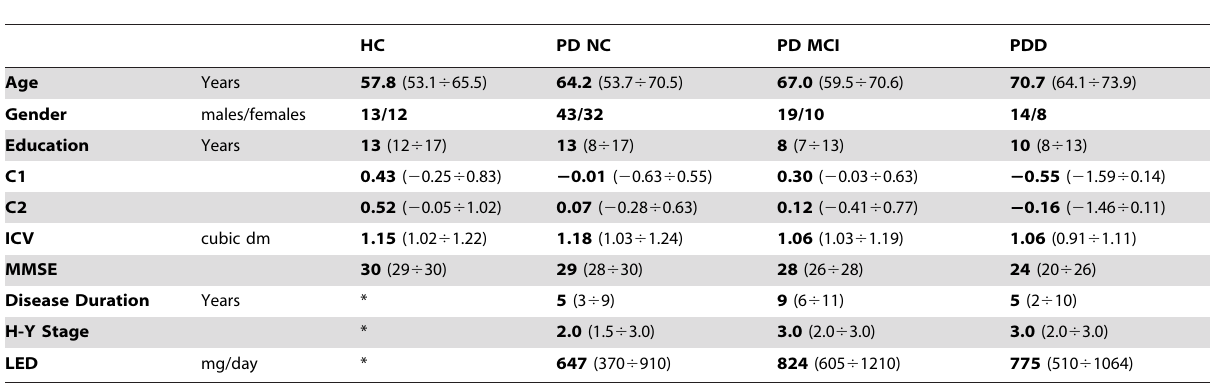
Table 1. Demographic and Clinical